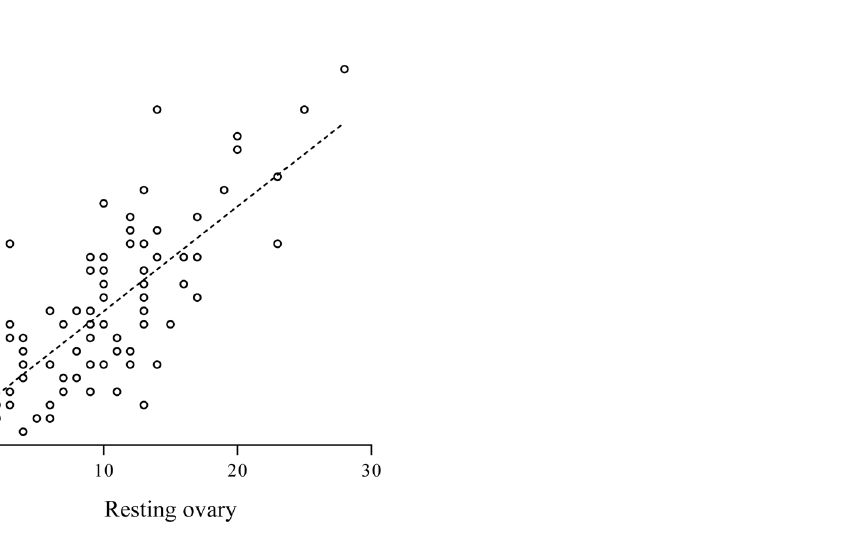
Figure 2. Number of follicles developing in the active (Y axis) and resting (X axis) ovaries. Each woman is represented by a single point. The dotted line represents the linear regression curve (Coefficient of correlation R 2 = 0.55, p <